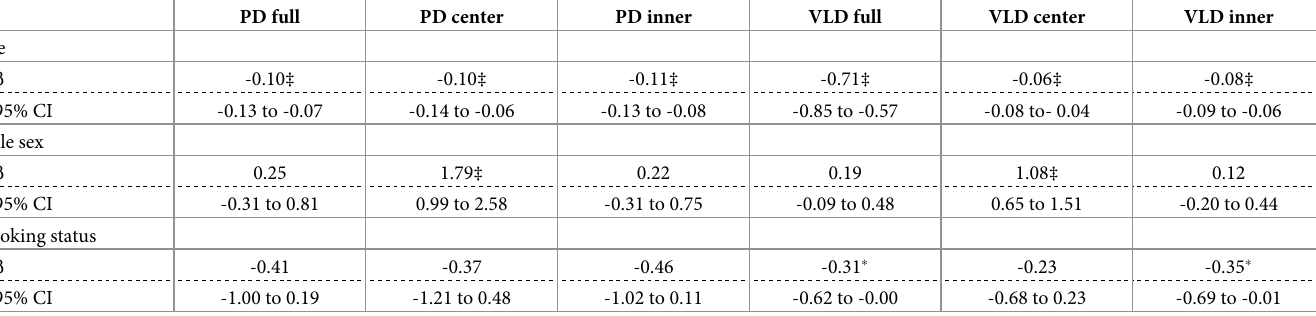
Table 3. Multivariate linear regression results of PD and